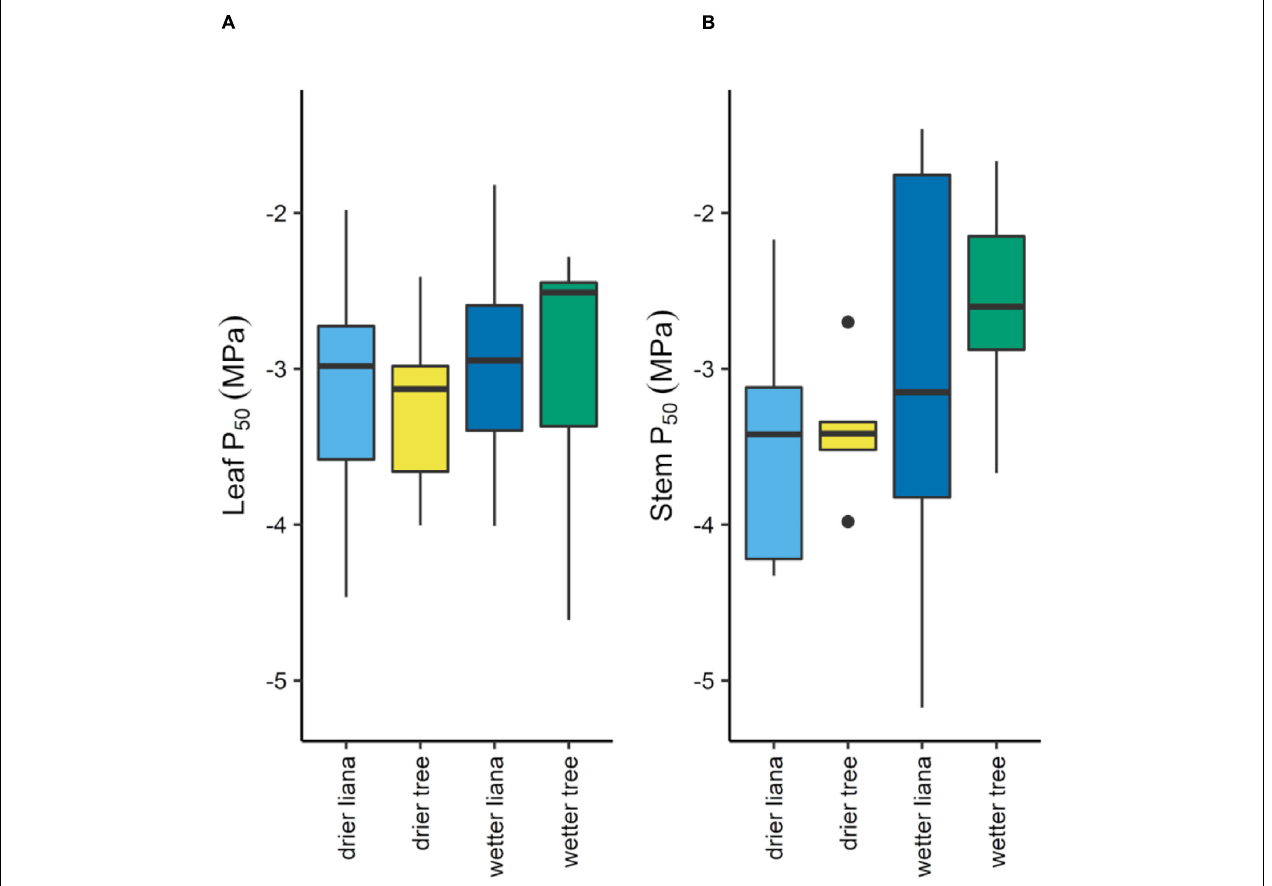
FIGURE 2 | Leaf (A) and stem (B) by growth form and forest type. Box plot midlines show medians, box edges, first and third quartiles, whiskers, minima and maxima, and points, outliers.